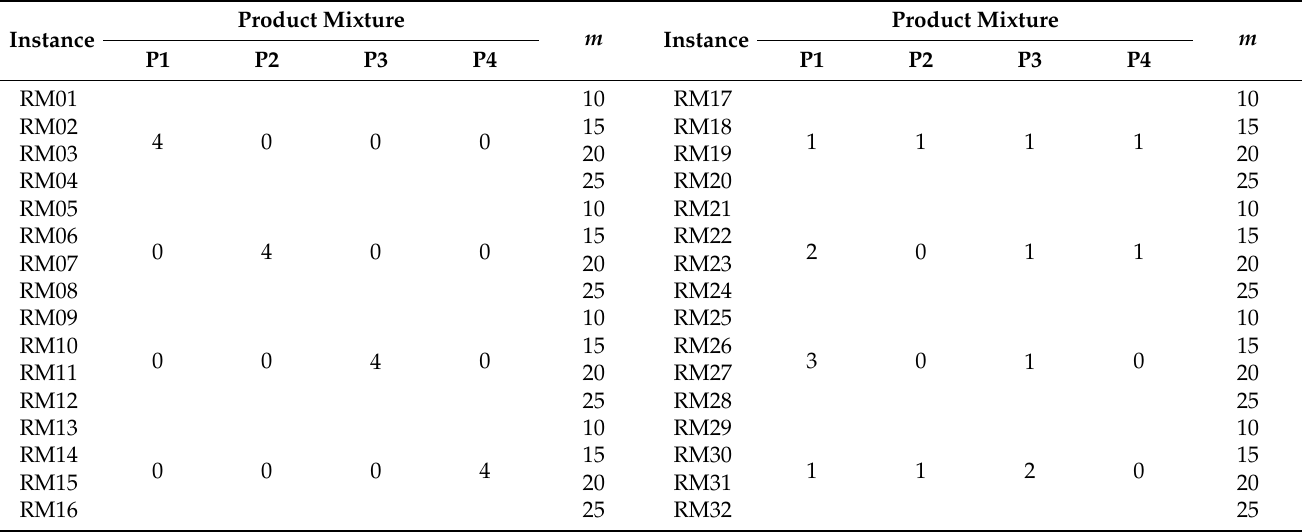
Figure 6. The tree-like structure of the four products. ( a ) Product 1; ( b ) Product 2; ( c ) Product 3; ( d ) Product 4. Table 2. Experimental instance.